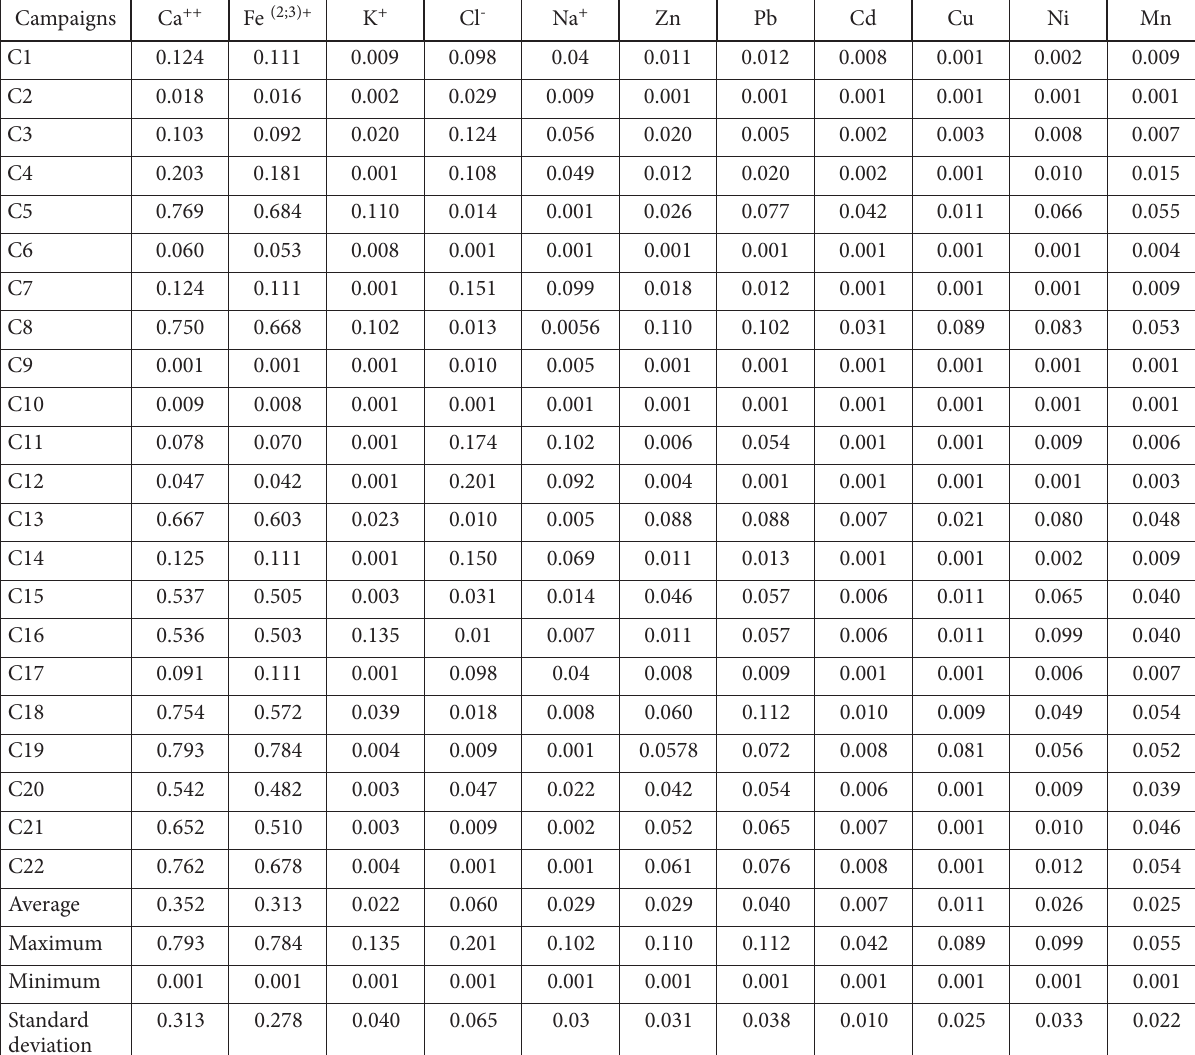
Table 3. Dry deposition fluxes of analyzed constituents (g/m 2 /14days) over S14 during the second period (from October, 2014 to August,